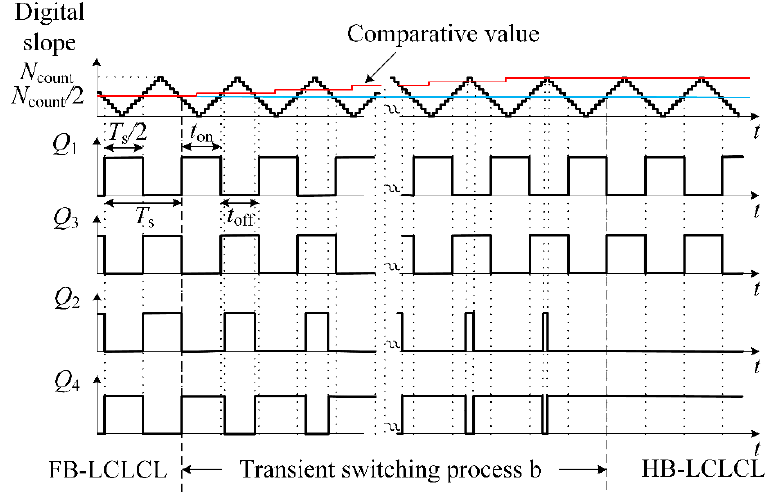
Figure 11. Adjustment of duty ratio for Q 1 – Q 4 with gradual control method during transient switching process b.